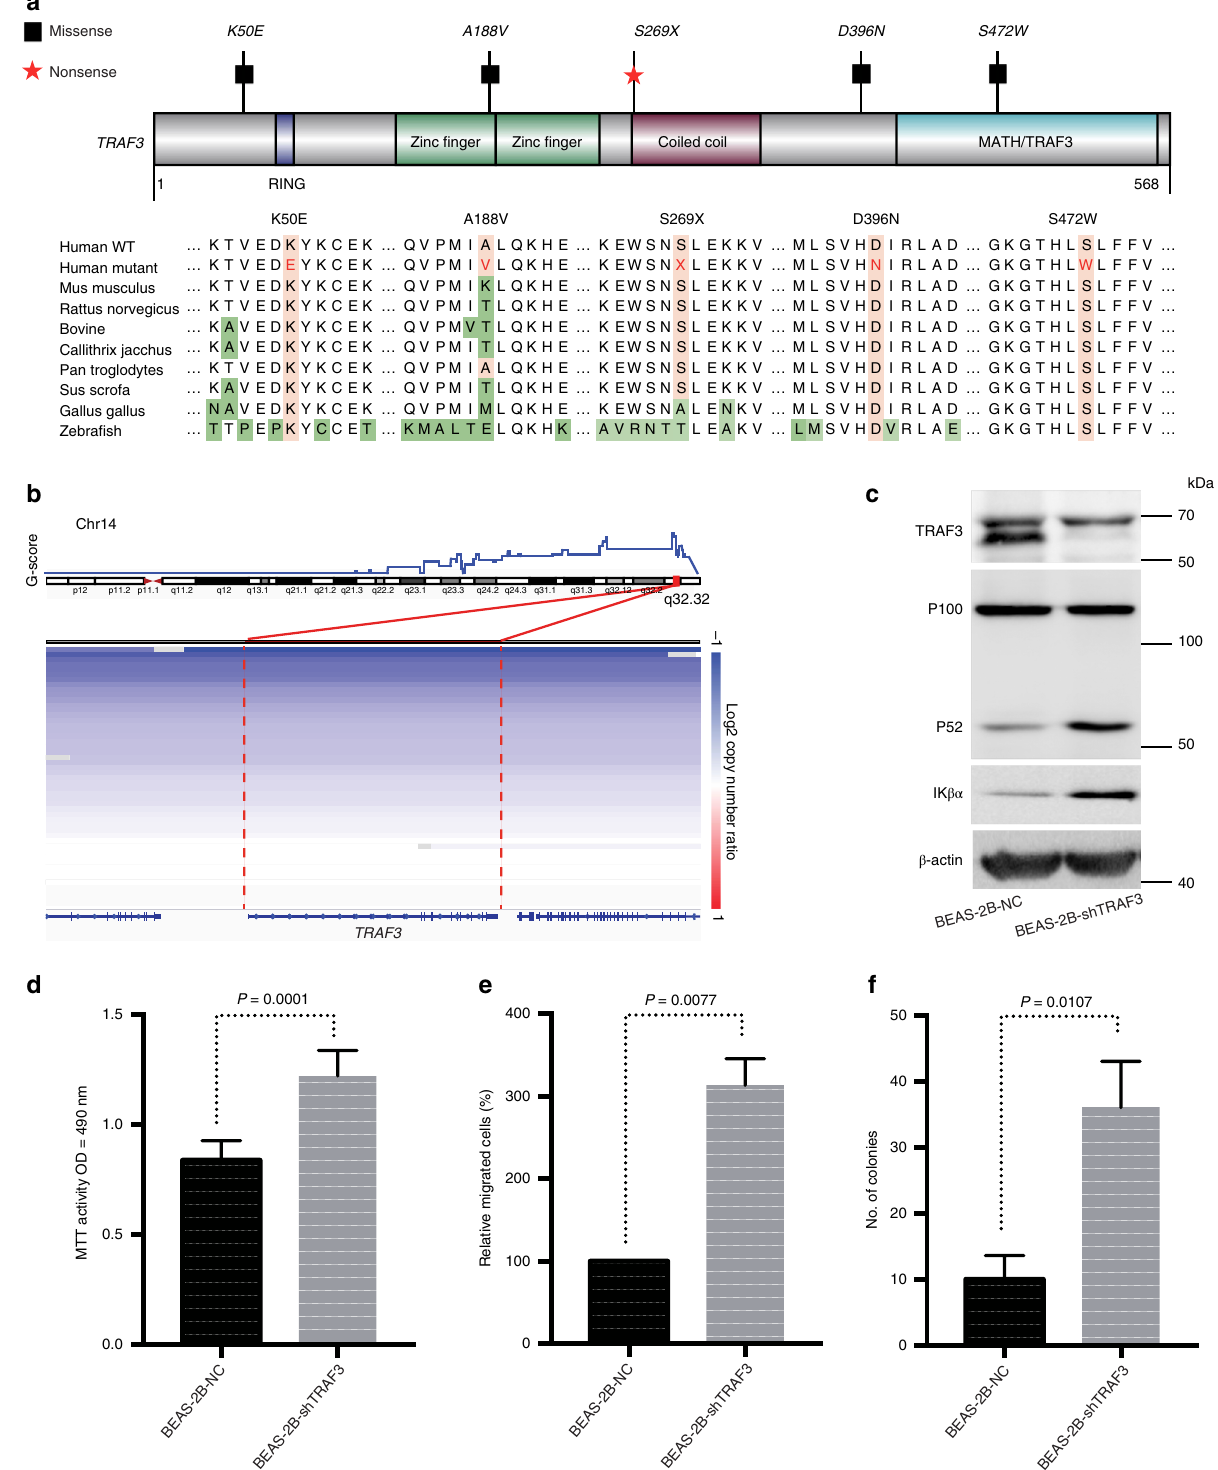
Fig. 4 TRAF3 alterations in pulmonary LELC. a Protein domain structure of TRAF3 based on UniProt database with mutated sites. Sequence alignment of TRAF3 protein across distinct species is shown. Amino acid positions of the mutations are indicated above the alignment. b Copy number deletions of TRAF3, samples are sorted by log2 copy number ratio. BEAS-2B cells either with or without knockdown of endogenous TRAF3 expression with short hairpin RNAs (shRNAs) were examined by western blot analysis ( c ), MTT assay ( d ), migration assay ( e ), and colony formation assay ( f ). Error bars in d , e , and f denote standard error of the mean. Experiments for d , e , and f were performed in triplicate. Student ’ s t -test was used for statistical analysis of d , e , and f . NC, normal control; MTT, 3-(4, 5-dimethylthiazol-2-yl)-2, 5-diphenyltetrazolium bromide; OD, optical